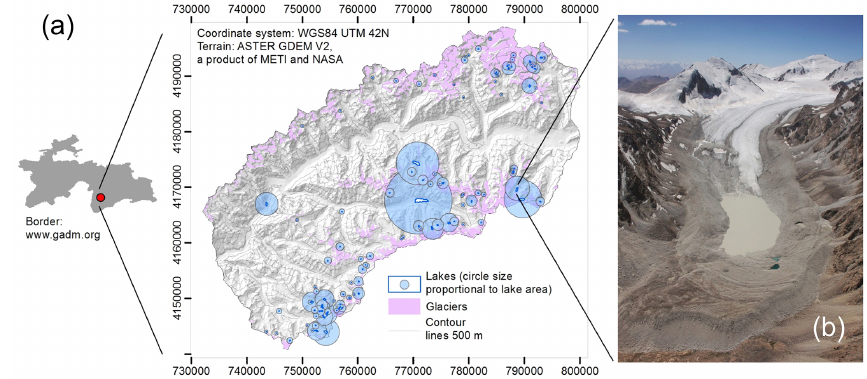
Figure 13. The test area in the Gunt Valley, Tajikistan. (a) Location, topography, glaciers and lakes. (b) Proglacial lake in the upper Varshedz- dara Valley; photo: M. Mergili, 18 August 2011. Table 5. Empirical–statistical relationships and simple rules used for computing the IIS of GLOFs in the Gunt Valley (see Table 3). IDtest